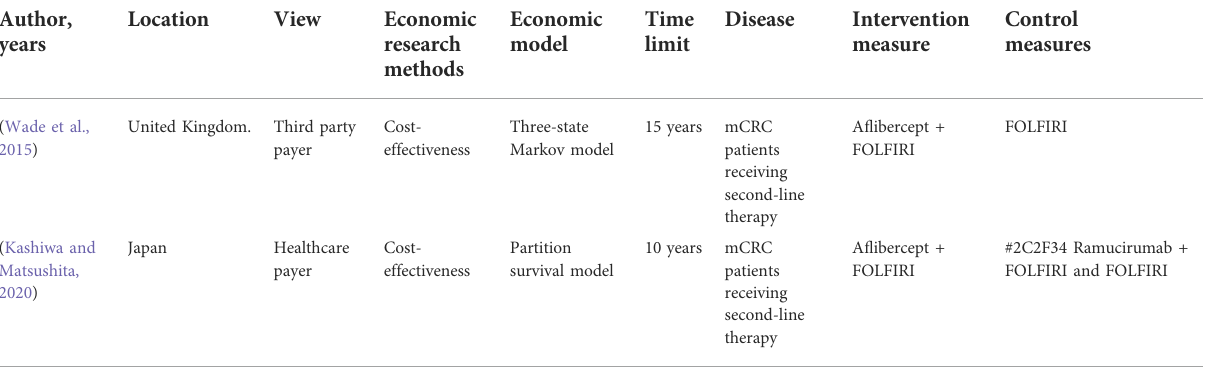
TABLE 4 Summary of included pharmacoeconomic